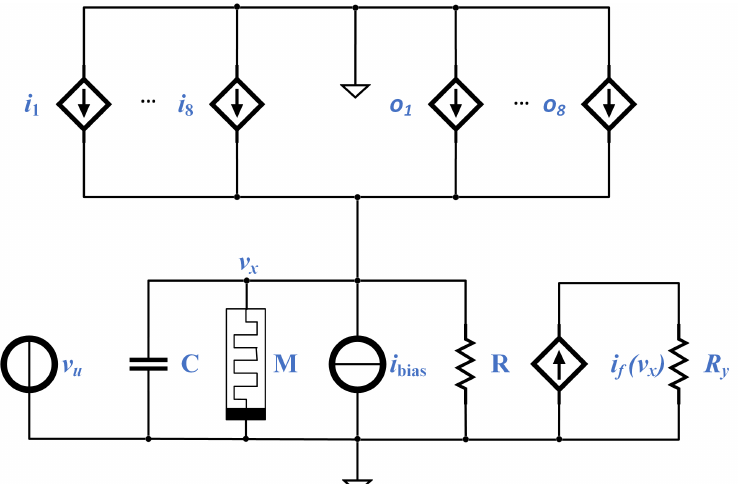
Figure 3. Schematics and Stochastic implementation of a CNN cell, the processing element in cell C ( i , j ) ( i ∈{ 1, . . . , M } , j ∈{ 1, . . . , N } ). The other elements (resistor, memristor, and capacitor) present the same values from cell to cell, i.e., C xi , j = C x , m xi , j = m x , and R yi , j = R y . Adapted from